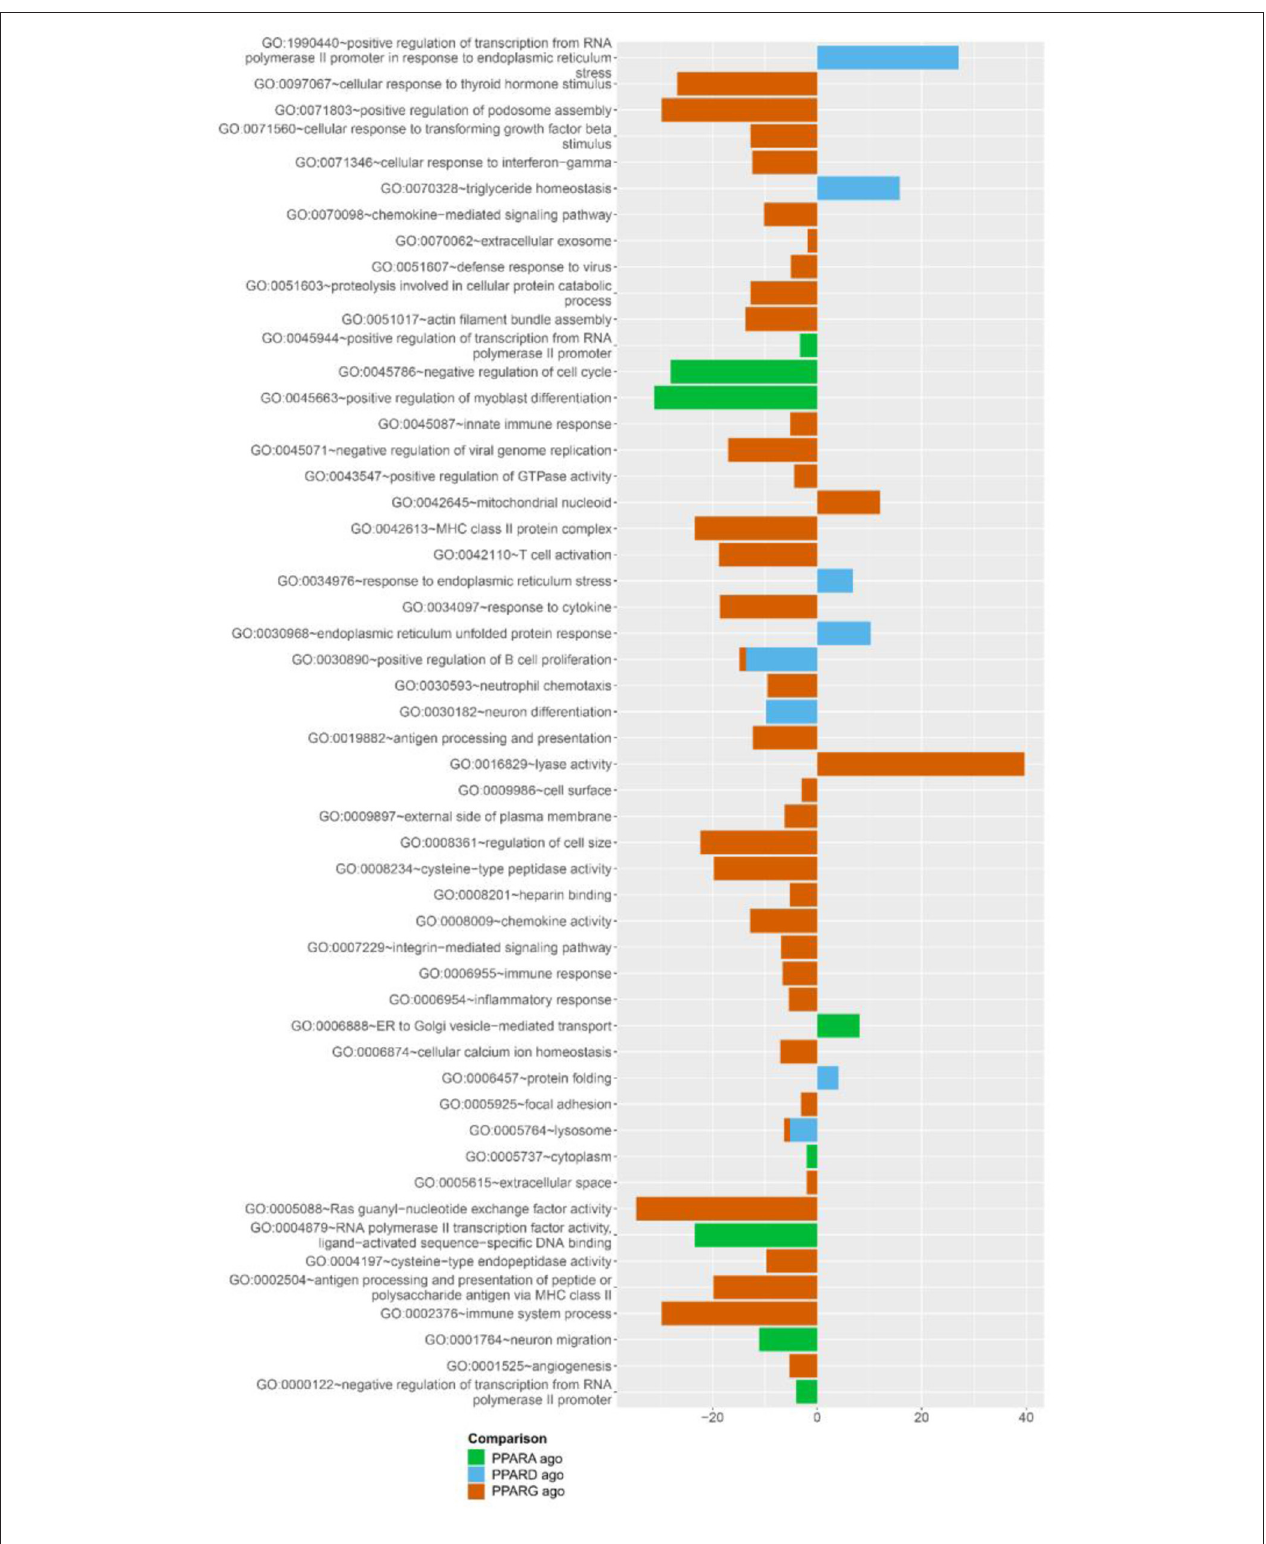
FIGURE 6 | Overrepresented gene ontology (GO) terms with a p -value < 0.01, according to DAVID, by the three PPAR agonists. Pathways associated with positive numbers are overrepresented in the subset of genes significantly upregulated by the treatment, whereas pathways represented by a negative number are overrepresented in the genes significantly downregulated by the treatment. Absolute numbers correspond to fold enrichment of the pathway.